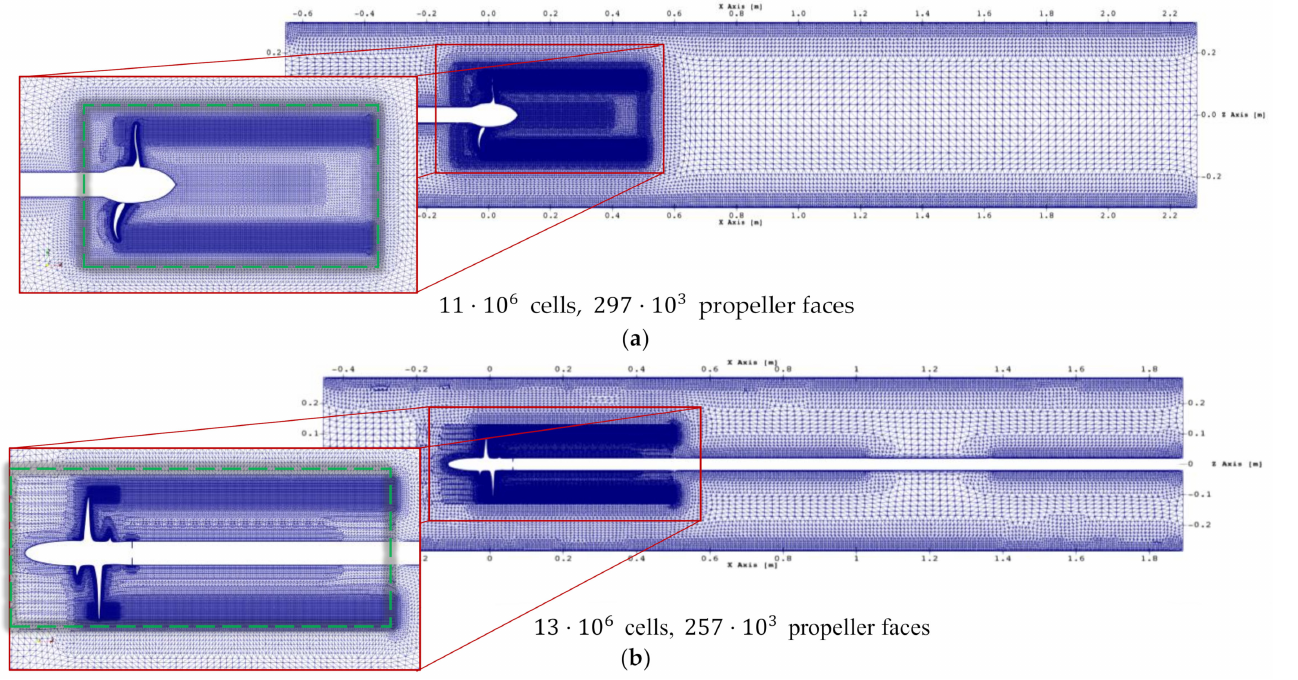
Figure 2. Initial mesh: ( a ) PPTC’11; ( b )